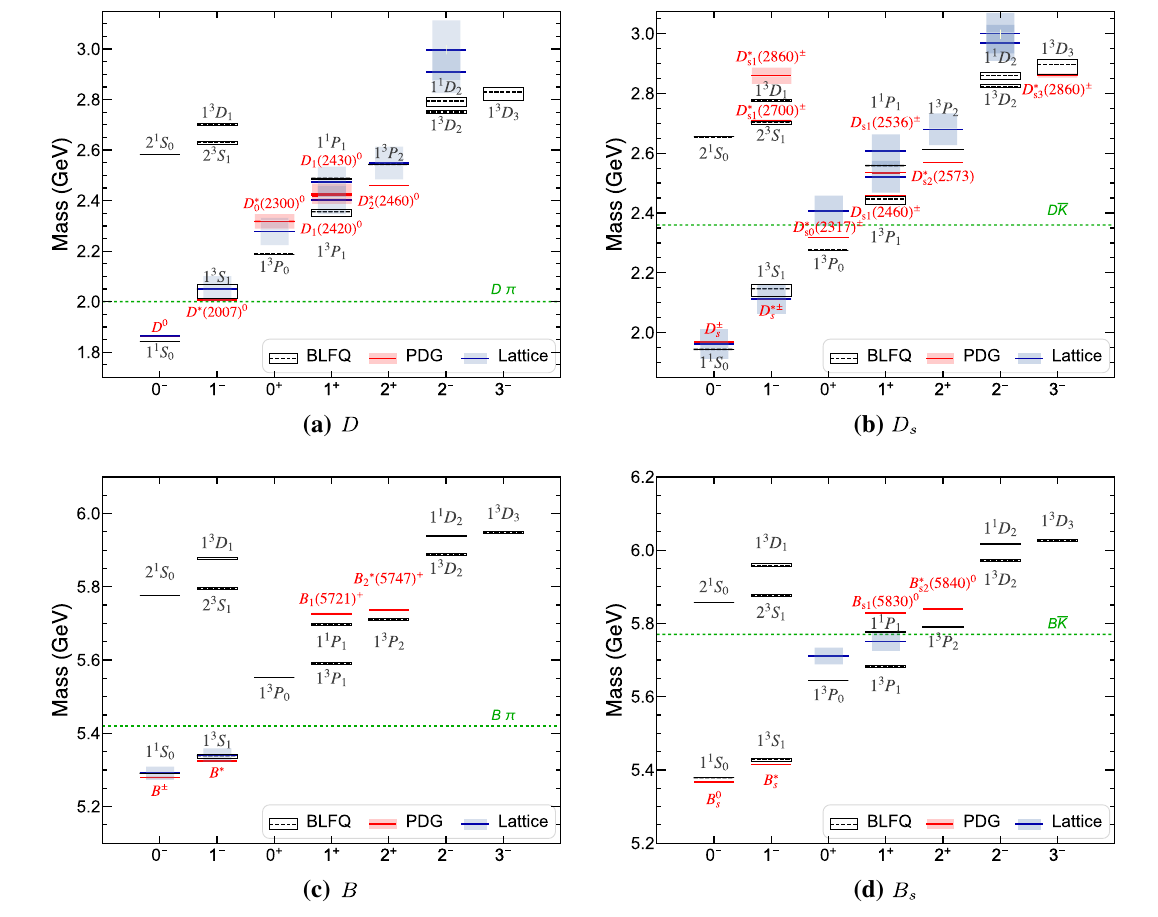
mental masses compiled by PDG [20]. Specifically, we use the values ¯ d ) from experiments for comparison. Shaded of D 0 ( c ¯ u ) and B ± ( b ¯ u / b blue bars are the Lattice QCD results from Refs. [21–24]. For both PDG and Lattice, we use the solid lines for the center values, while shaded boxes to indicate the